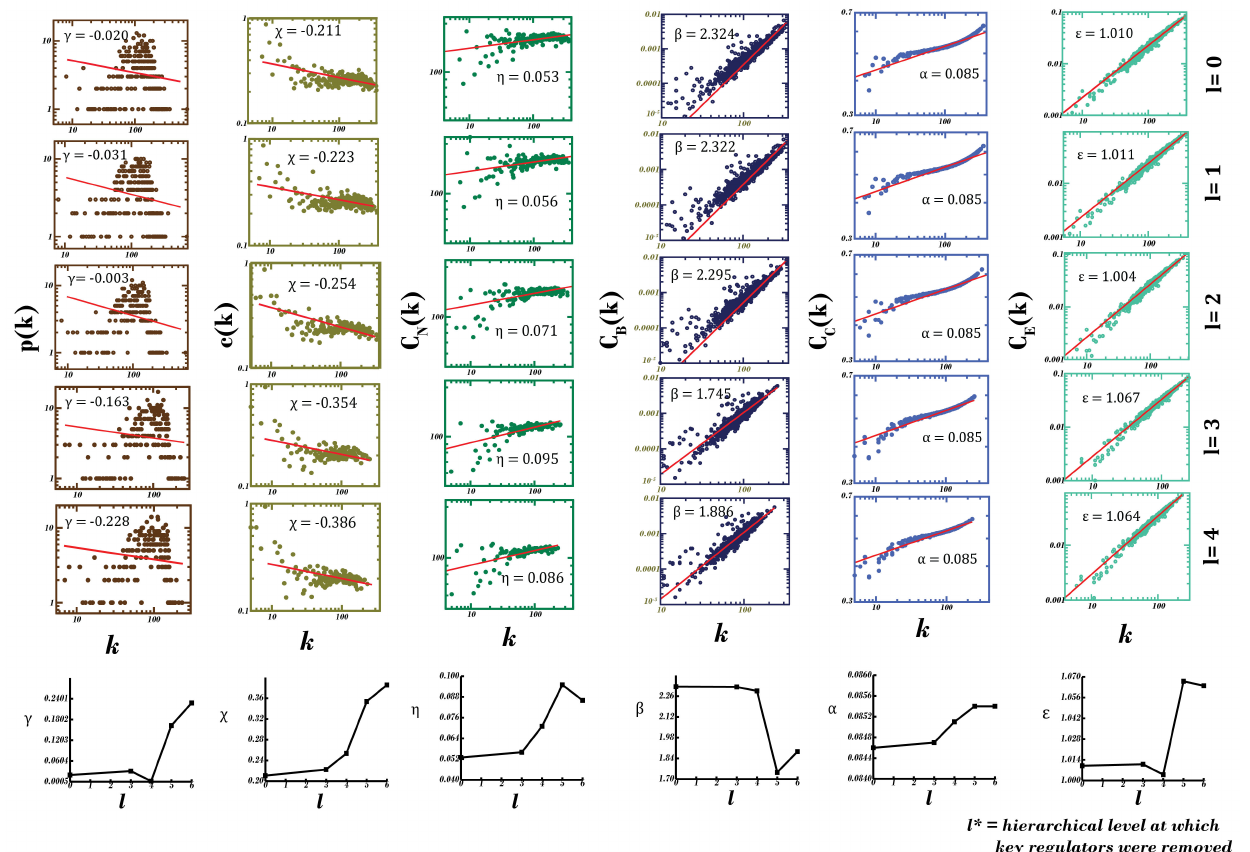
Figure 5. Analyses of topological properties (degree distribution p(k), average clustering coefficient c(k), neighborhood connectivity distribution C N (k), betweenness centrality C B (k), closeness centrality C C (k) and eigenvector centrality C E (k)) of the network after subsequent elimination of high-degree, motif-localized hubs found at each hierarchical level (l). Here, l = 0 represents topological properties of the principal dementia network. This knockout experiment depicts the importance of motif-localized hubs in the principal dementia network, as the network converts into a scale-free network from a hierarchical scale-free network, with subsequent eliminations showing its loss in